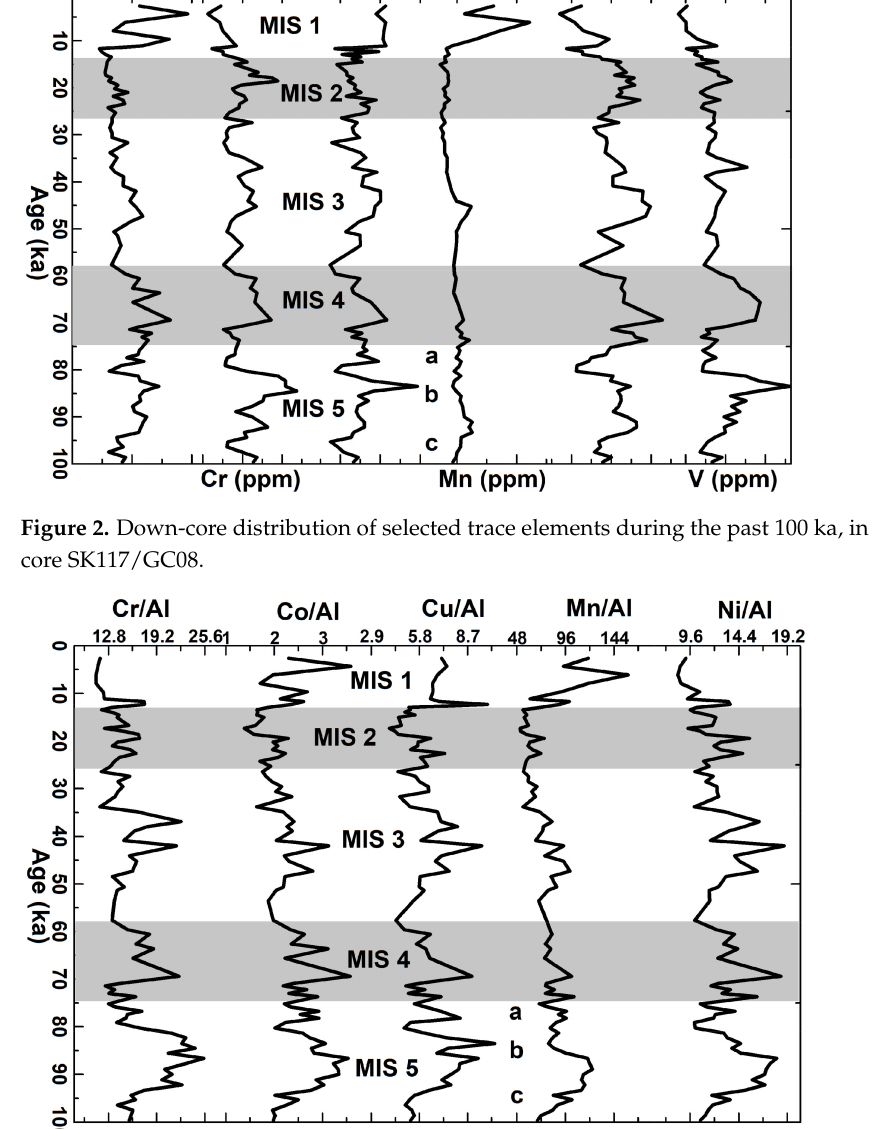
Figure 3. Down-core distribution of ratio of trace elements with respect to aluminium in the sediment core SK117/GC08 from eastern Arabian Sea during the past 100